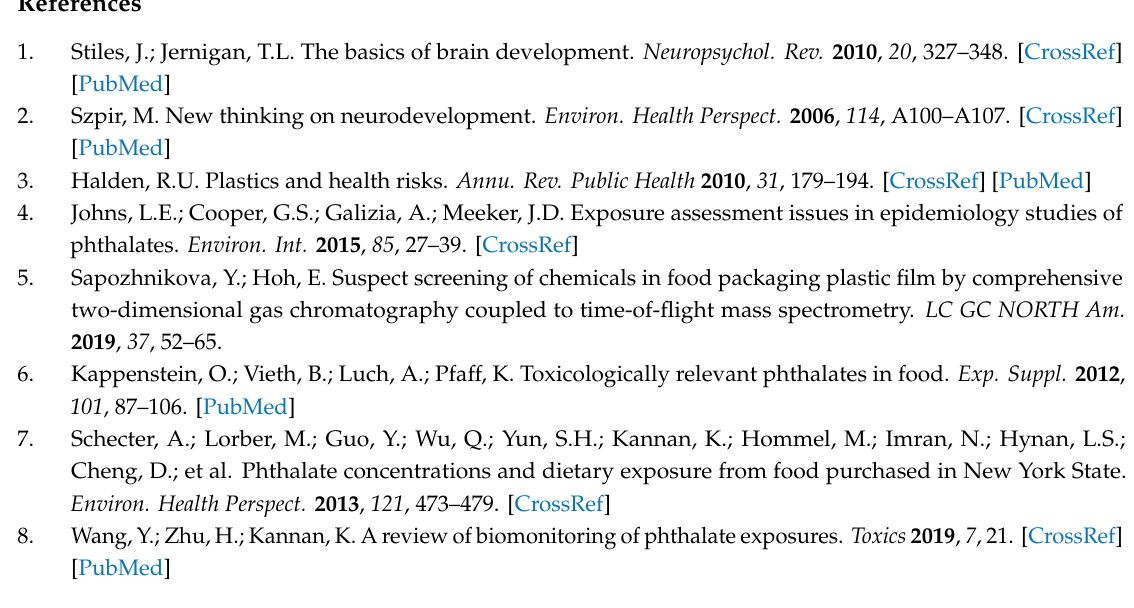
Table S1: Linear associations between urinary phthalate metabolites pregnancy geometric mean and McCarthy Scales of Children’s Abilities; Table S2. McCarthy Scales of Children’s Abilities and individual geometric mean and sum of urinary levels of phthalate metabolites association by linear regression models, stratified by sex; Table S3. Adjusted regression coe ffi cients for change in McCarthy Scales of Children’s Abilities associated with a 2nd trimester ln-unit increase in urinary phthalate metabolite concentration, stratified by sex; Table S4. Adjusted regression coe ffi cients for change in McCarthy Scales of Children’s Abilities associated with a 3rd trimester ln-unit increase in urinary phthalate metabolite concentration, stratified by sex; Table S5. Median urinary phthalate metabolites levels during pregnancy, measured in di ff erent